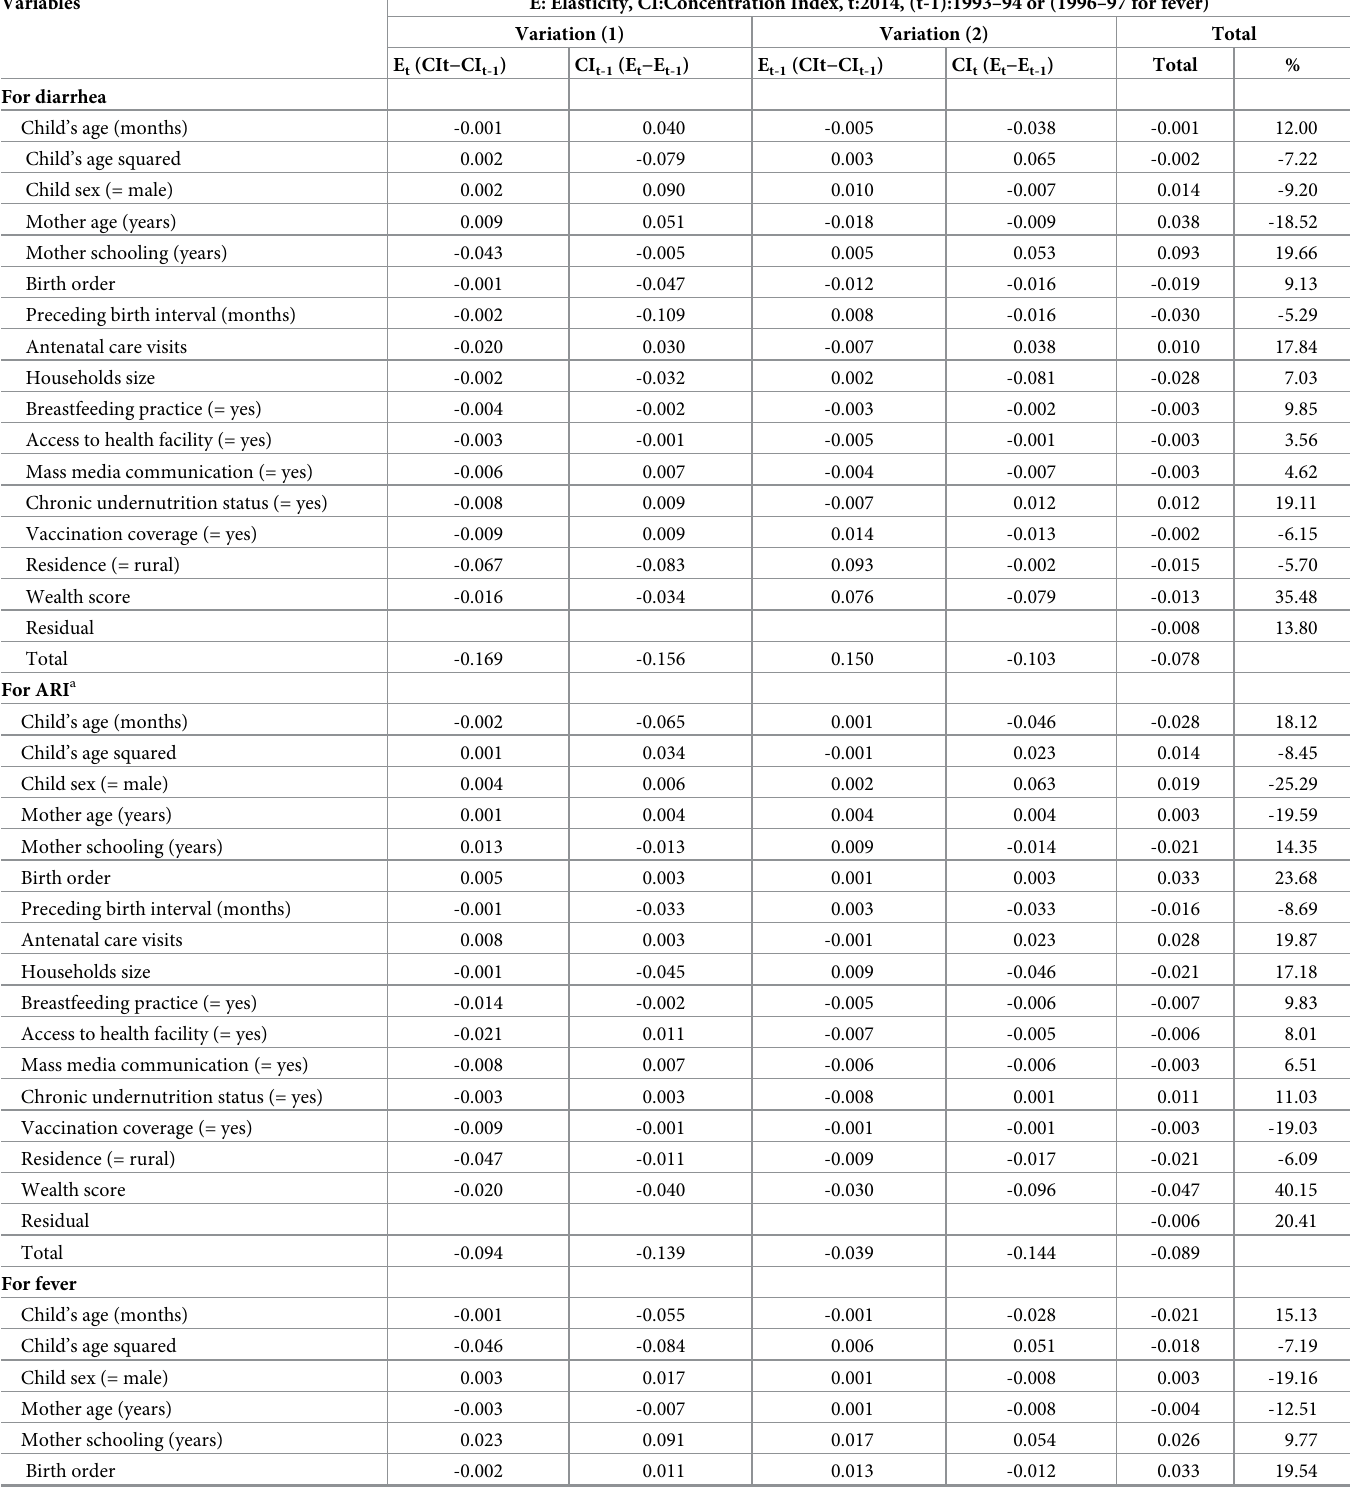
Table 2. Oaxaca-type decomposition for change in inequality for childhood morbidity, 1993–2014.